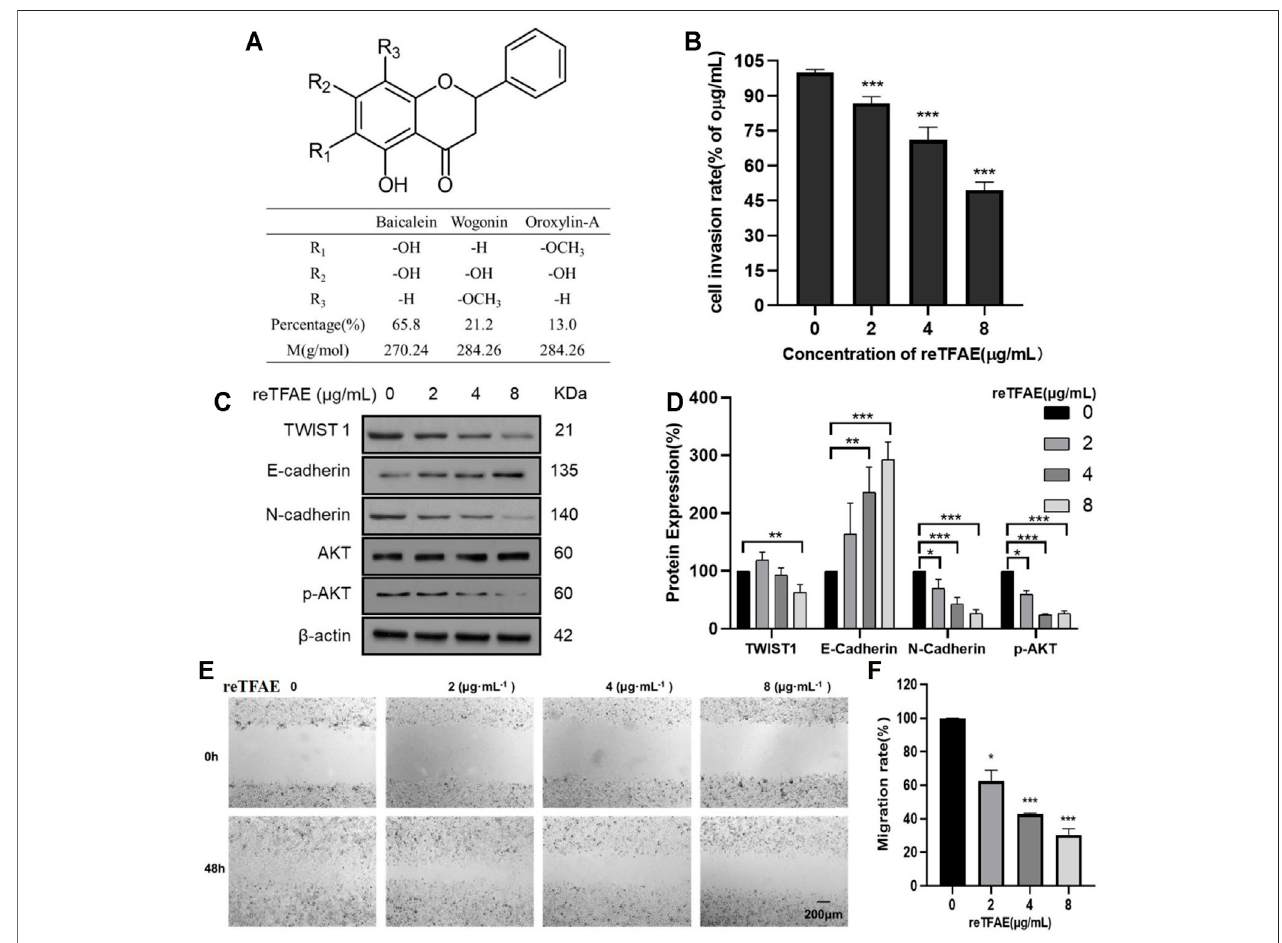
FIGURE 1 | reTFAE inhibited EMT processes of A549 cells. (A) The structure and proportion of the components of reTFAE. (B) The invasion-inhibiting ability of reTFAE on A549 cells ( n = 3). (C,D) Effects of different concentrations of reTFAE on the expression of EMT-related proteins ( n = 3). (E,F) reTFAE inhibited A549 cells ’ migration ( n = 3). Statistical differences were determined by a two-sided Student ’ s t -test; Compared with 0 μ g/ μ l TFAE. *** p < 0.001; ** p < 0.01; * p < 0.05.